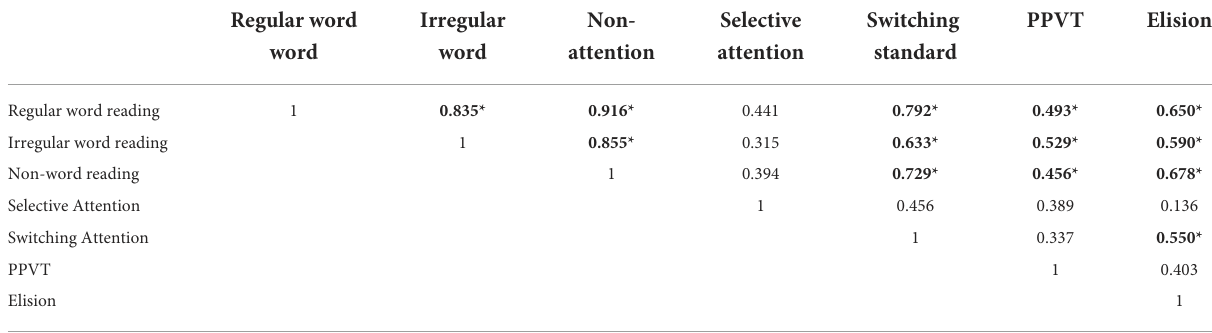
TABLE 7 Pearson correlation for word reading, visual attention, receptive vocabulary, and the phonological processing measure of elision. Standardized scores were used in the analysis. Regular word Irregular Non- Selective